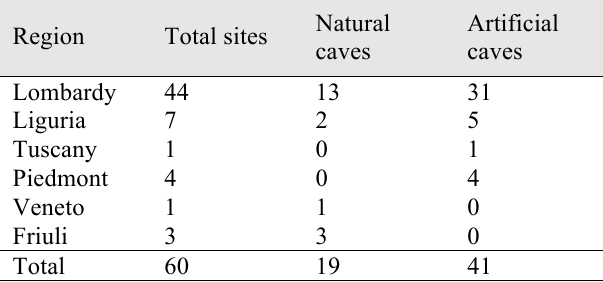
Table 3. Number of Italian underground sites in which fire salamander breeding occurred; data represent combination between field surveys and an extensive literature